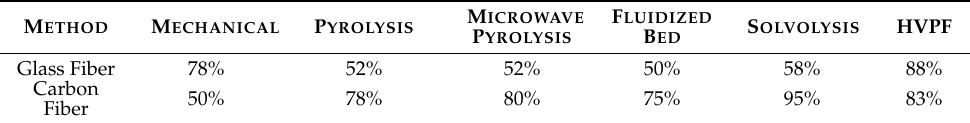
Table 2 . Retained tensile strength from the different EoL options compared to virgin fibers. (Inspired by [55]).